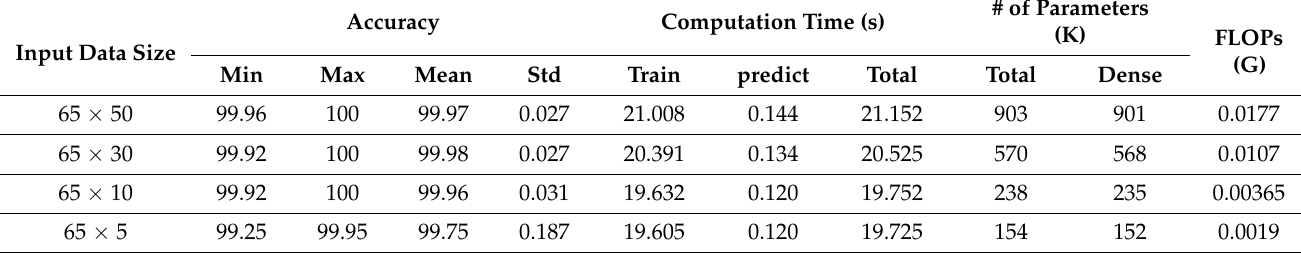
Table 4. Comparison of bearing fault diagnosis accuracy, performance, and computation complexity measures (computation time, number of parameters, and Flops) of models using each different input data size.